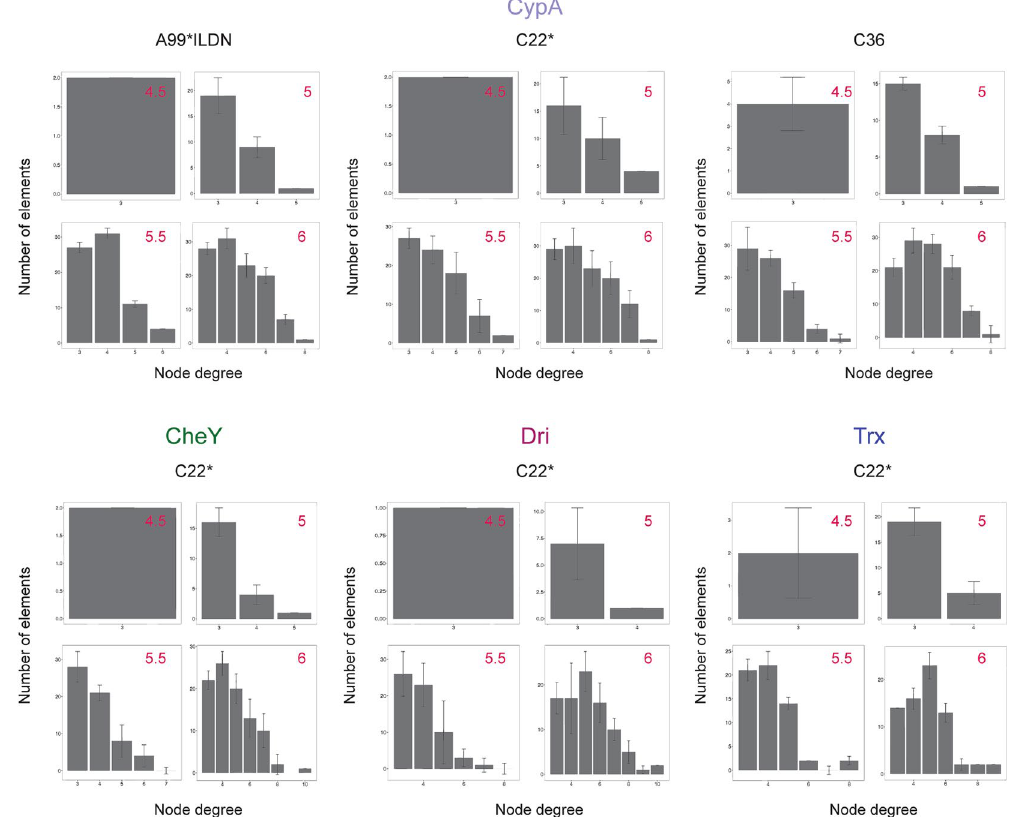
Figure 3. Hub distribution at different distance cutoffs used for the PSN-MD analyses. We evaluated the changes in the number of hubs and their node degree as a function of different distance cutoffs in the PSN derived from the entire MD trajectory (histogram values) and the associated standard deviations (error bars) calculated from the average PSNs obtained from the Jackknife resampled trajectories (see Materials and Methods). We noticed that hubs are virtually absent at distance cutoffs lower than 5